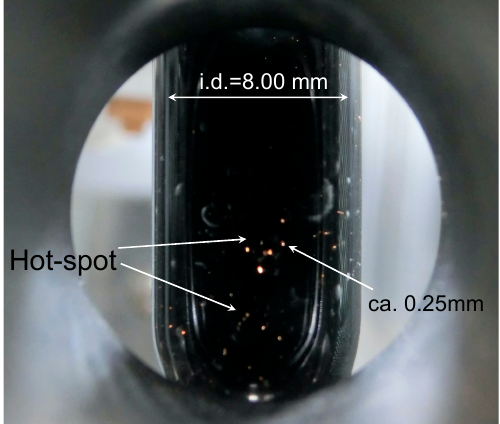
Figure 3. Photograph of the arc discharges (hot-spots) occurring on the Pd particles deposited on activated carbon (Pd/AC) particle particulates in toluene/1-hexanol solvent during the reaction in a quartz reactor (internal diameter, 8.00 mm; external diameter, 10.0 mm) under 6-W microwave irradiation at the fixed microwave frequency of 5.85 GHz.